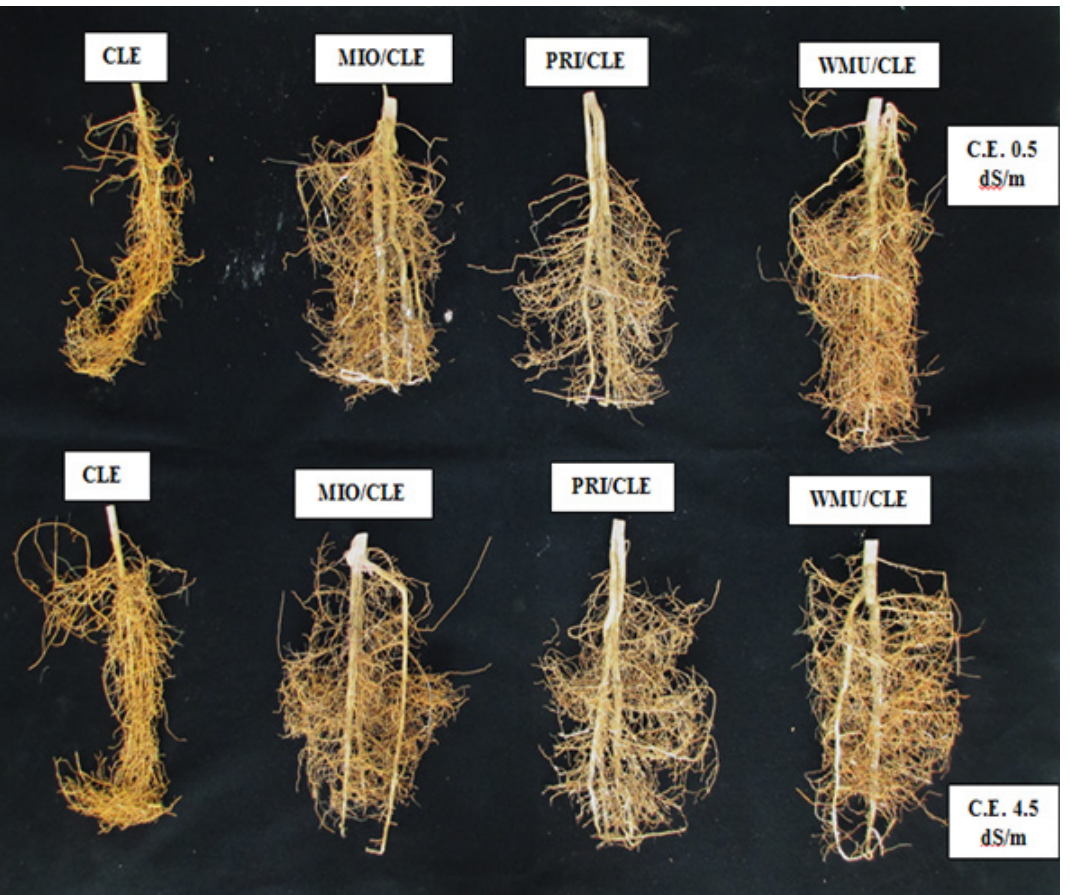
Figure 3. Effects of salt stress on roots for each scion/rootstock combination at 90